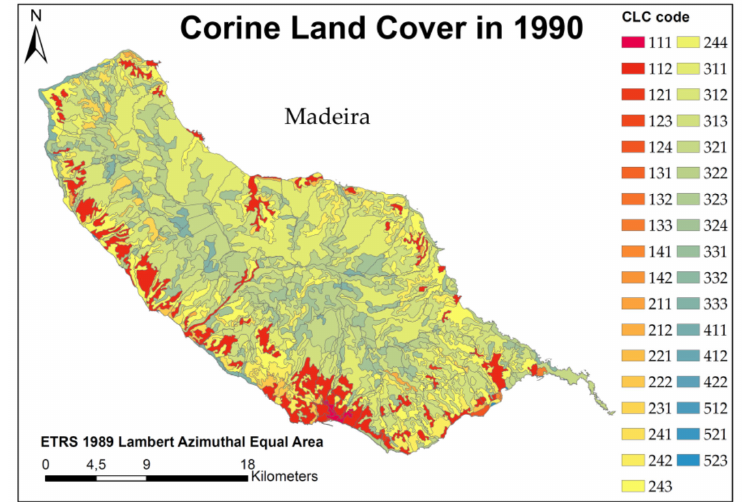
Figure 11. Thematic cartography regarding the land-use changes in the Madeira Archipelago in the year 1990.